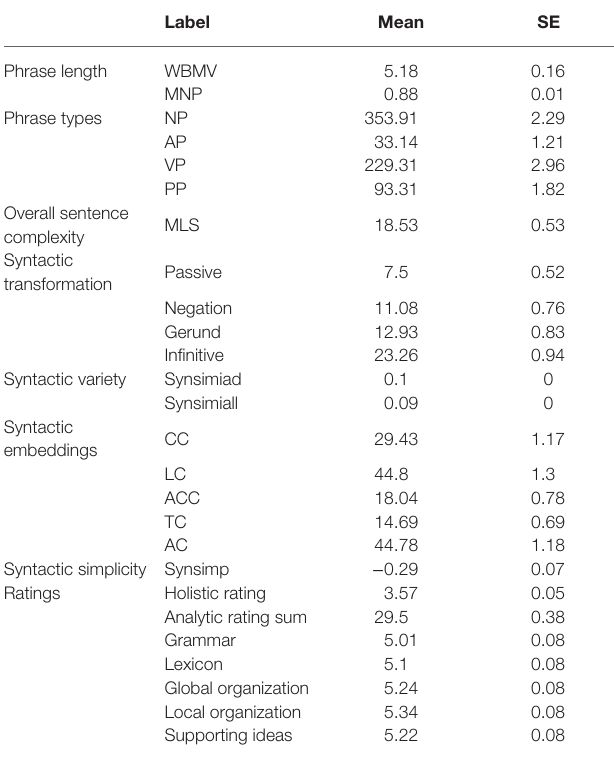
TABLE 2 | Descriptive data of English as a foreign language argumentative writings for the present